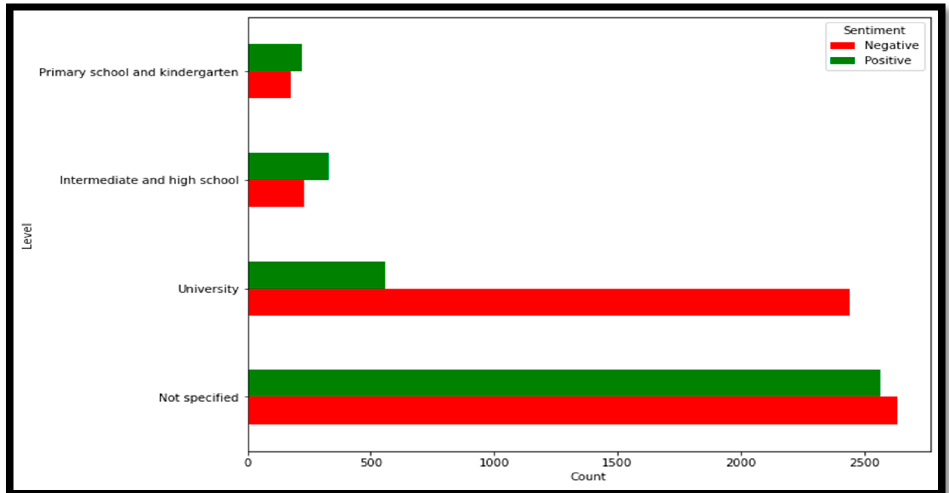
Figure 6. The opinions regarding distance learning in Saudi Arabia for different educational stages.